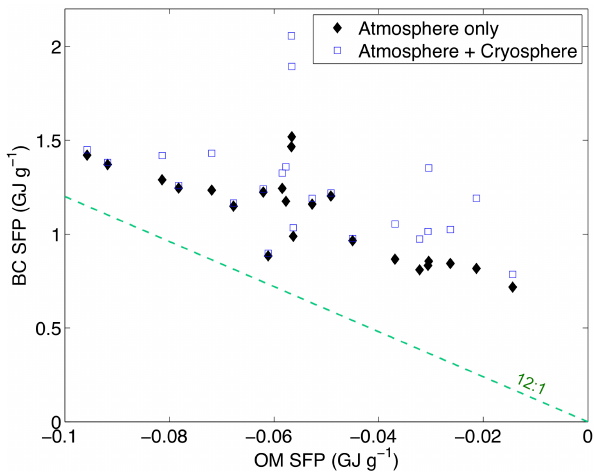
Fig. 10. SFP for black carbon plotted versus SFP for organic matter for all 23 source-region combinations. A line which intercepts the origin and which has a slope of the OM:BC ratio from a particular source divides direct warming from direct cooling (above/below) by that source. The 12:1 line is given here because that OM:BC ratio is the highest of all the major sources. Therefore, central estimates for SFP indicate that the OM plus BC mix results in direct warming for all sources, although uncertainties are